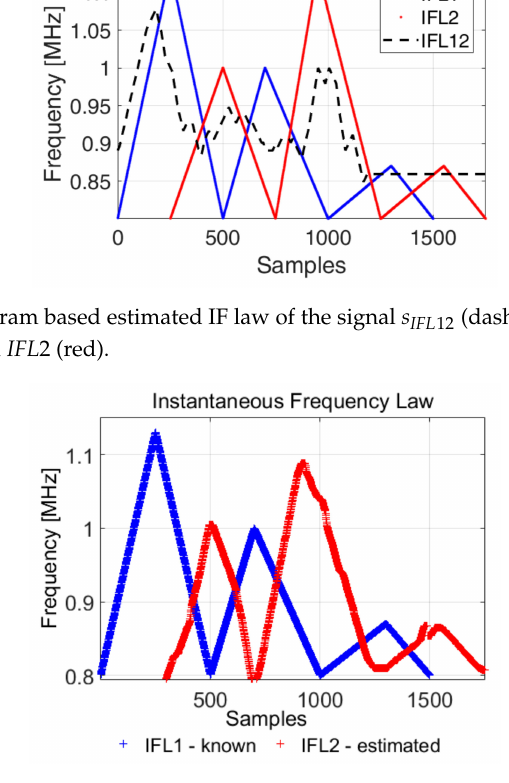
Figure 18. The phase space based estimation of the overlapped IF laws: IFL 1 is known, IFL 2 is estimated.